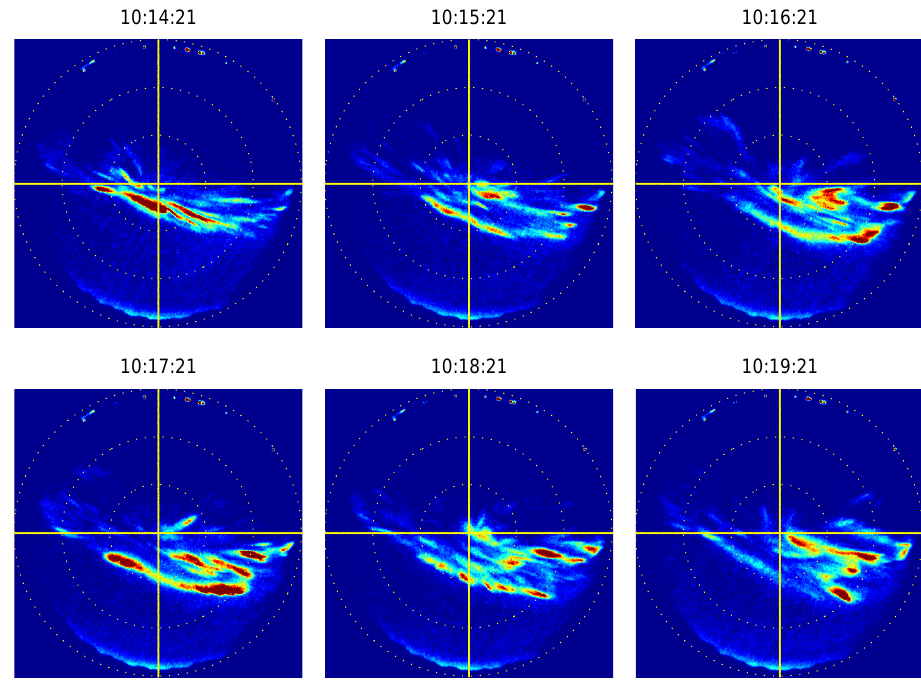
Fig. 6. Ny ˚Alesund ASC observations at 557.7nm for the interval 10:14–10:17 UT on 3 December 1997. The reference frame is zenith angle (dotted circles at 30, 60, and 90 ◦ ) and azimuth. Same format as in Fig. 4. The integration time is 1s.